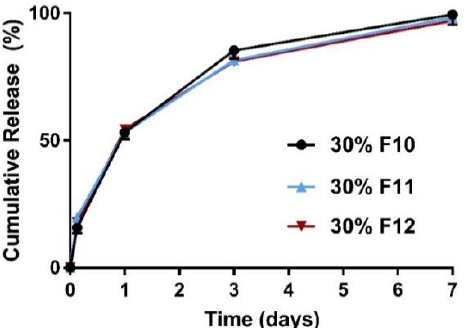
Figure 2. Comparison of mean (±SEM) in vitro ketamine release profiles between microparticle formulations ( n = 3) with ketamine loading at 60% and 30%, 20% and 10%. The 24 h burst release decreased significantly (****, P < 0.0001) from 74.6% (● F2, 60% ketamine and 40% PLGA5050-1.5E) to 27.7% ( ■ F5, 30% ketamine and 70% PLGA5050-1.5E). Reducing the ketamine load from 30% to 20% and 10% using the same polymer, PLGA5050-1.5E, enabled the polymer matrix to have better control over ketamine release. Sustained release continued for 14 days when ketamine loading was 30% ( ■ F5), whereas it lasted more than 21 days at 10% ketamine loading ( ▼ F6). The 24 h burst release was reduced significantly from 27.7% to 9.0% (*, P < 0.05) for microparticles at 10% ketamine loading when compared with 30% ketamine loading. Ketamine loading at 20% ( ▲ ) and 30% ( ■ ) did not differ significantly ( P > 0.05) in terms of release duration, but burst release was reduced from 27.7% to 17.5%. Two-way ANOVA followed by the Bonferroni test. F, Formulation.